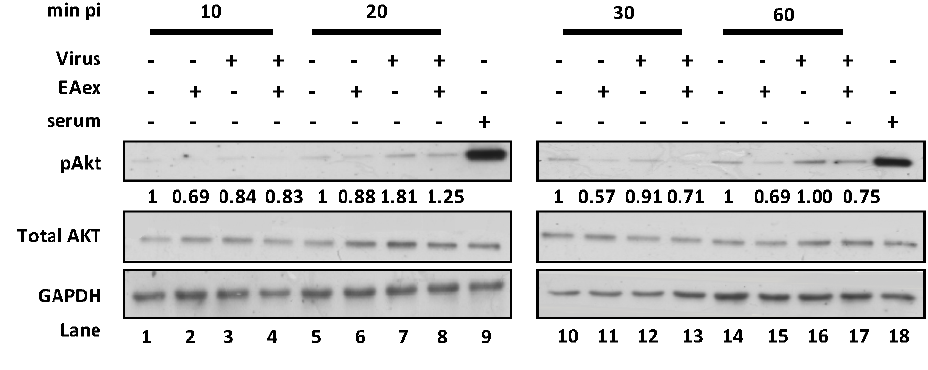
Figure 2. EAex inhibited the influenza virus-induced pAKT pathway. Influenza A/WSN/33 (MOI: 0.1) was incubated with 0.025 mg/mL on ice for 1 h. The mixture was then used to infect A549 cells, which had been incubated overnight in serum-free medium. Cell lysates were harvested at 10, 20, 30, and 60 min after virus addition, and GAPDH, AKT, and pAKT (S473) were detected by immunoblotting. P: positive control; A549 cells were incubated in serum-free MEM for 24 h before treatment with 2% FBS in MEM for 1 h. These figures are representative of three independent, reproducible experiments. Relative pAKT expression was normalized with AKT, and then normalized to the mock infection at each time